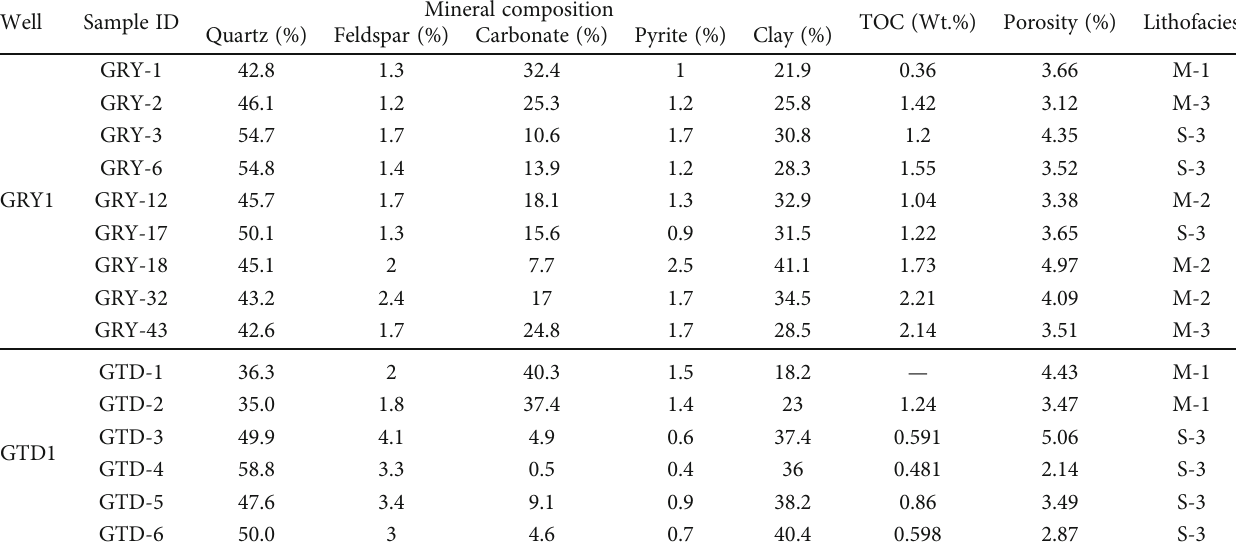
Table 1: TOC, mineral composition, and lithofacies of shale samples in GRY1 and GTD1. Mineral composition Well Sample ID